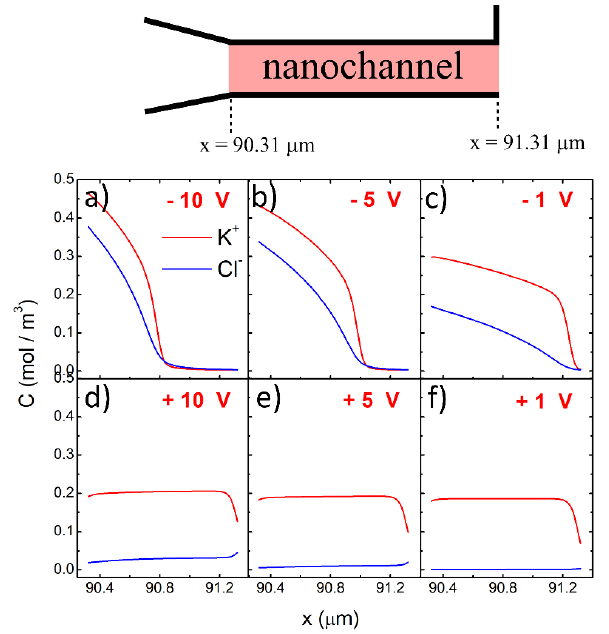
Figure 6. K + (red line) and Cl − (blue line) ion concentration along the longitudinal section of the nanochannel for different applied voltages: ( a ) -10 V, ( b ) -5 V, ( c ) -1 V, ( d ) 10 V, ( e ) 5 V and ( f ) 1 V, between the reservoirs (C Bulk = 10 −5 M =10 −2 mol/m 3 ).